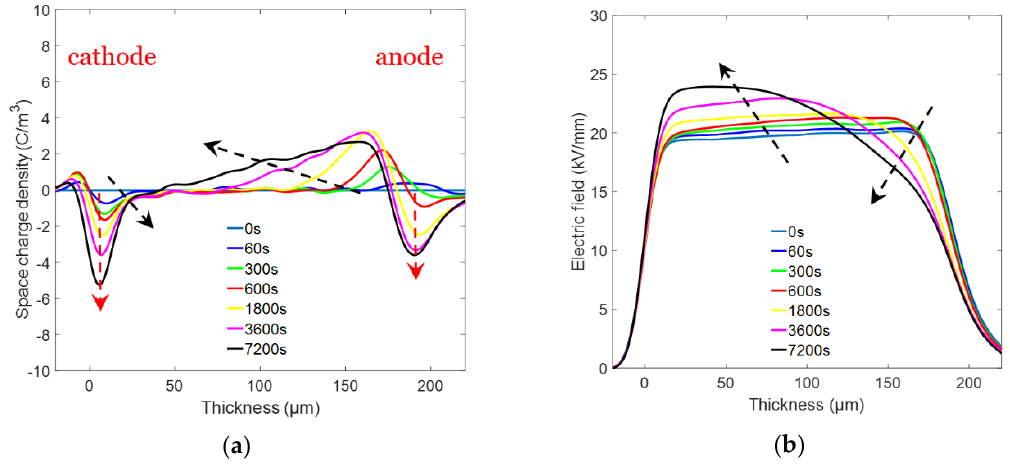
Figure 2. ( a ) Space charge behaviour in LDPE film at 20 kV/mm field under room temperature (capacitive charge removed). ( b ) Electric field distribution over the insulation thickness of the LDPE.